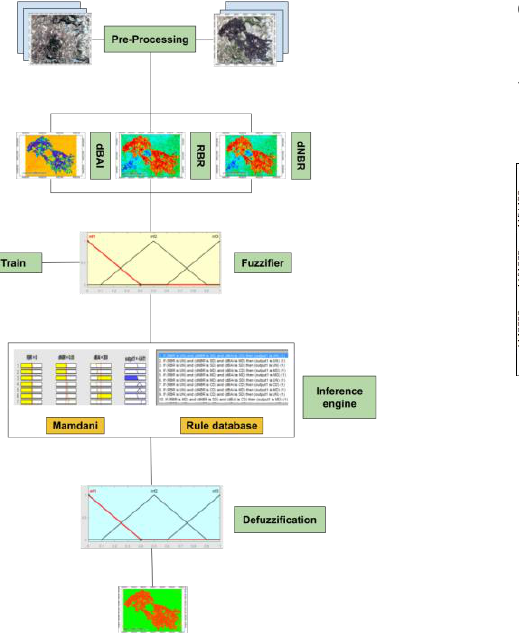
Figure 2. Flowchart summarizing the suggested processing of Classification